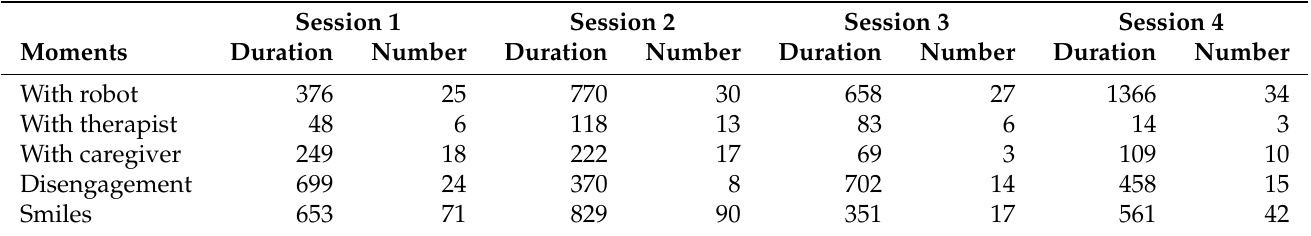
Table 1. Duration (seconds) and numbers during the five types of